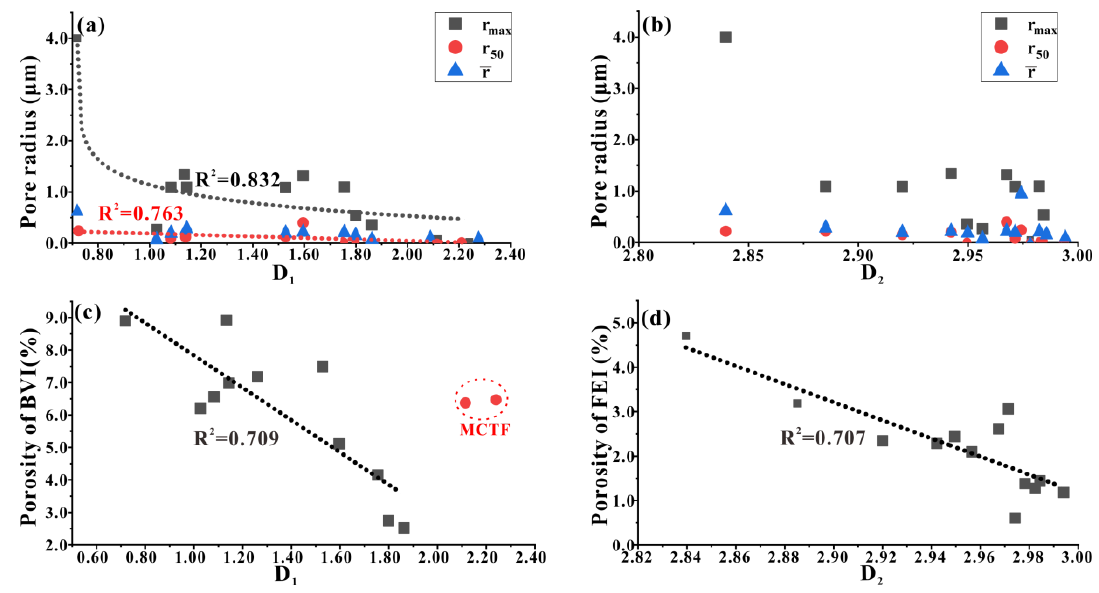
Figure 15. Relationships between the fractal dimensions and pore structure parameters. ( a ) Pore radius (maximum radius, median radius, and average radius) vs. D 1 ; ( b ) pore radius (maximum radius, median radius, and average radius) vs. D 2 ; and ( c ) D 1 vs. φ BVI ( d ) D 2 vs. porosity of movable fluid (FFI).